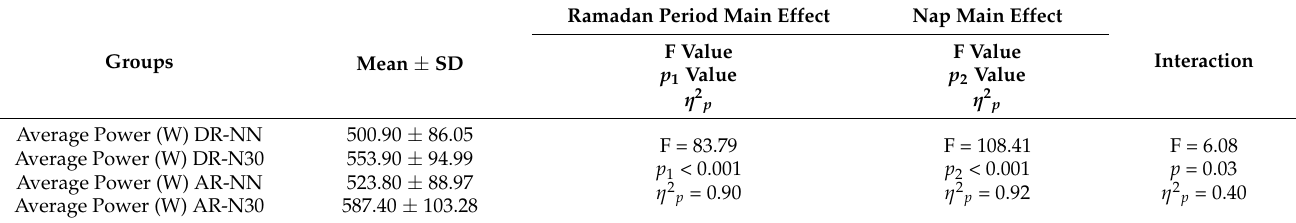
Table 3. Comparison of the measured values of the Average Power (W) (n =